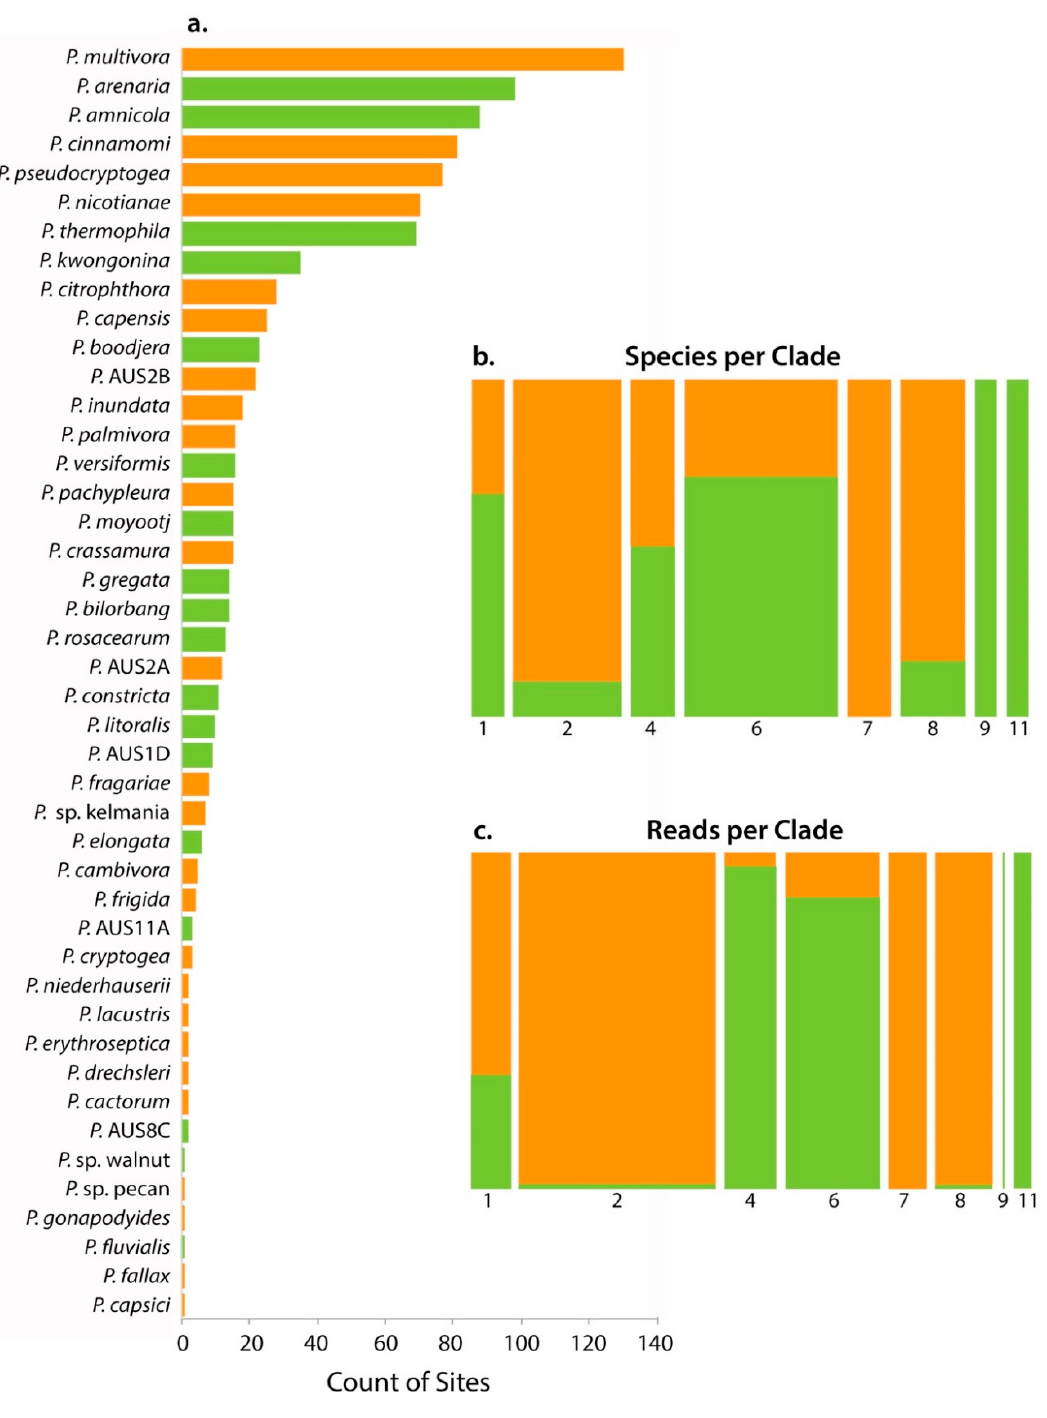
Figure 2. ( a ) Rank-frequency curve for the 44 Phytophthora species detected in this study by metabarcoding. Orange bars are the putatively introduced taxa while green denotes putatively native status. Mosaic plot showing the distribution of native and introduced Phytophthora species by ( b ) the number of species per clade—the bar width is proportional to the number of species, ( c ) rarefied read number per clade—the bar width is proportional to the number of reads. Bar heights ( b , c ) show the relative proportion of native: introduced Phytophthora phylotypes per clade.